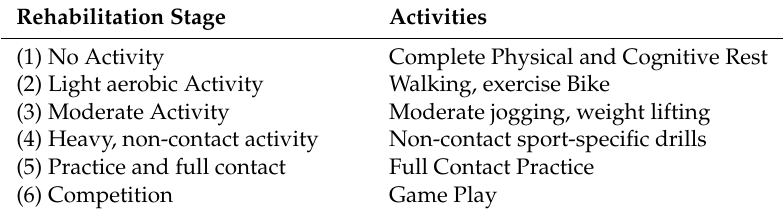
Table 2. Graduated return to sport strategy after a concussive injury